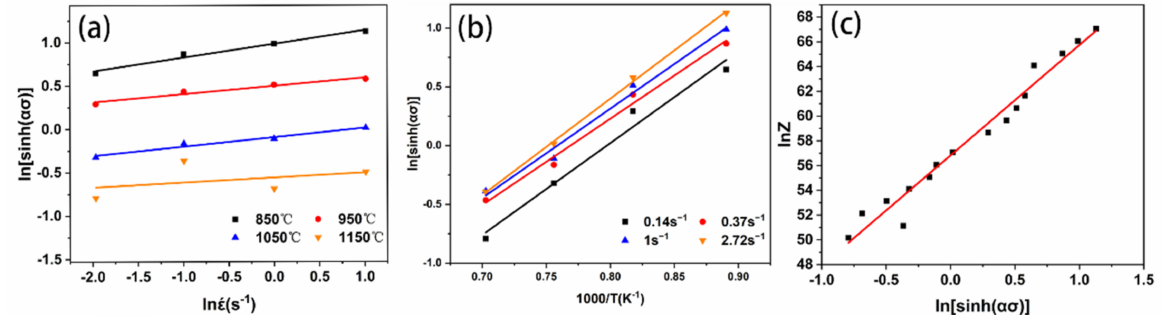
Figure 3. Relationship between: ( a ) ln´ ε − ln[sinh( ασ )], ( b ) 1/T − ln[sinh( ασ )], and ( c ) lnZ − ln[sinh( ασ )].